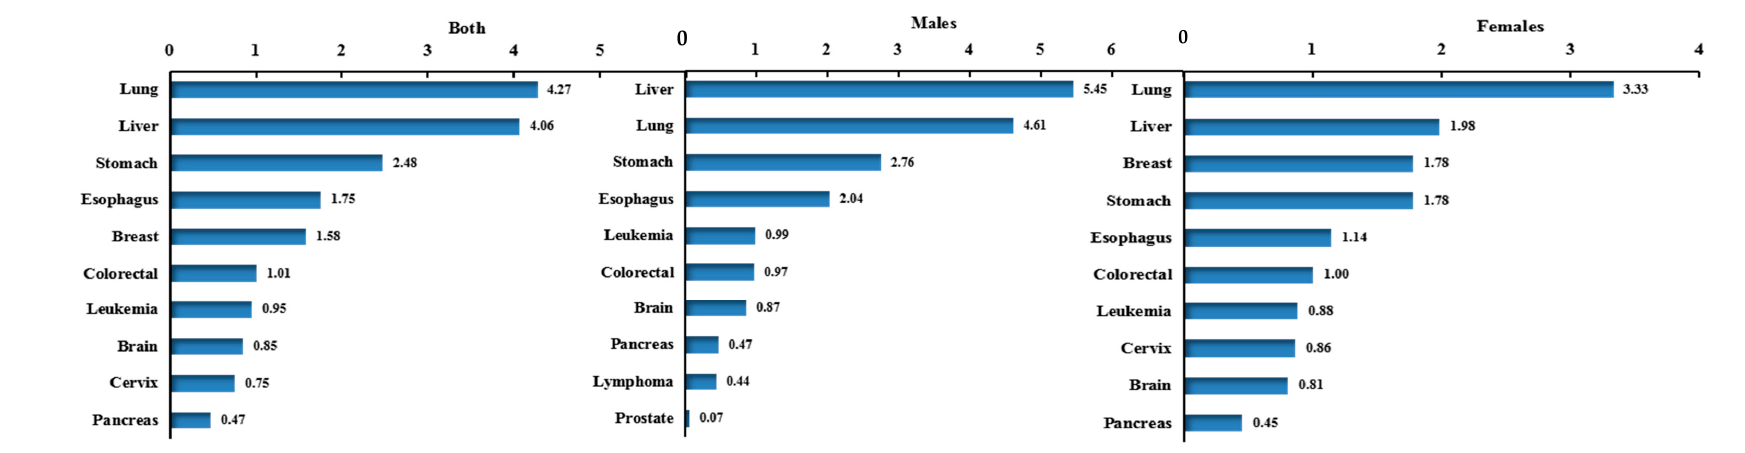
Figure 2. Cont. Figure 2.